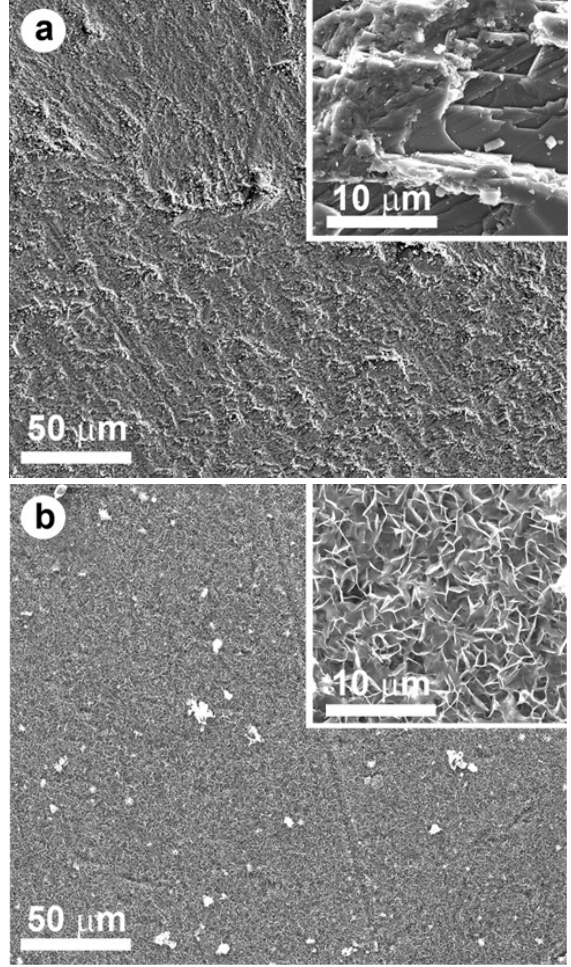
Figure 1 . SEM images of Carrara marble surface before (a) and after (b) treatment with a 1 M DAP and 1 mM CaCl 2 solution. Continuous coating of marble surface with a new calcium phosphate coating (composed of both HAP and OCP) can be observed after treatment